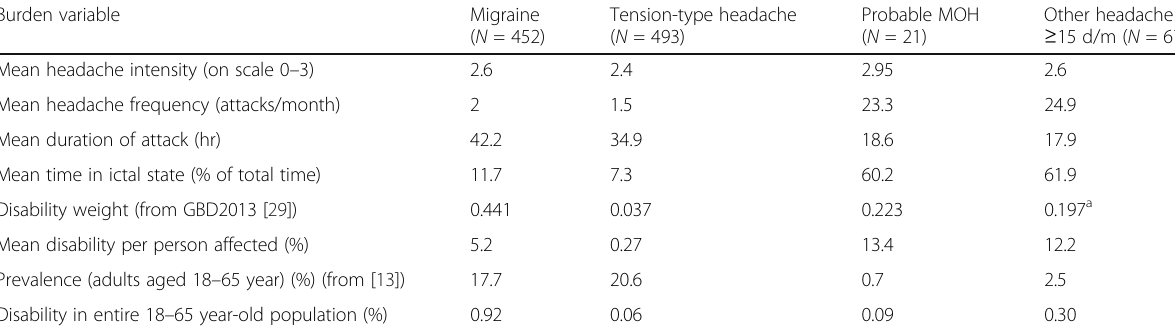
Table 1 Symptom and disability burdens by headache type, at individual and population levels Burden